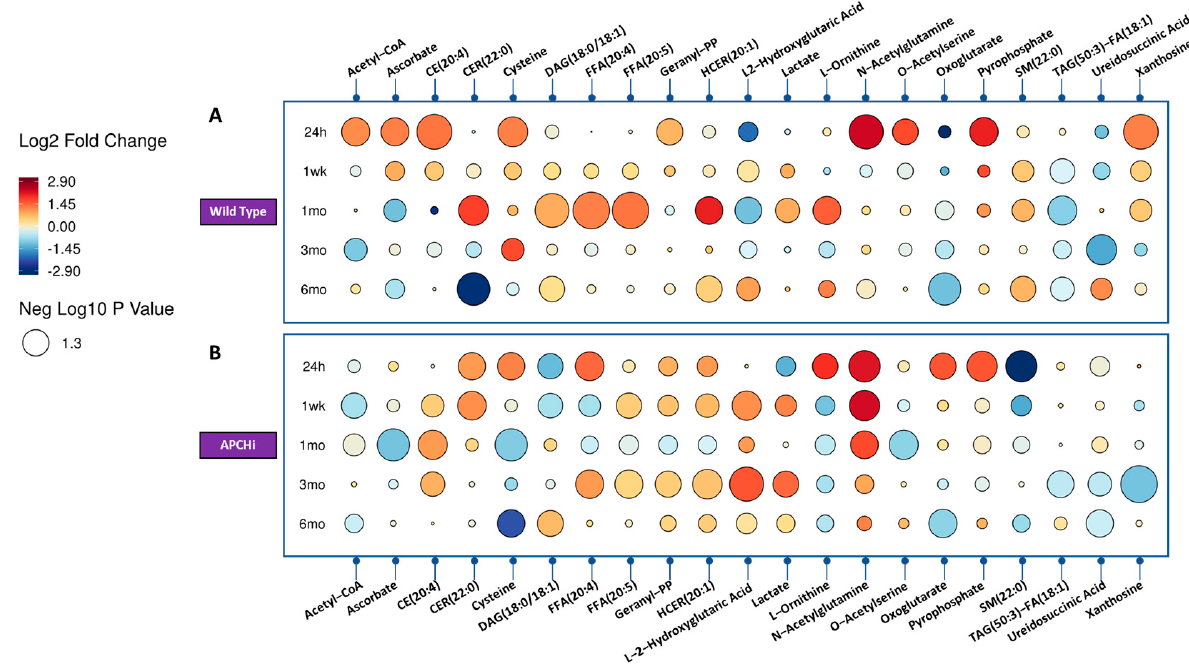
Figure 2. Raindrop illustration of metabolites altered in urine at di ff erent time points in Wild Type (Panel A ) and APCHi (Panel B ) mice. The colors of each circle represent fold change, with red representing an increase and blue representing a decrease. The size of the circle represents the level of statistical signi fi cance, with larger circles indicating greater statistical signi fi cance.